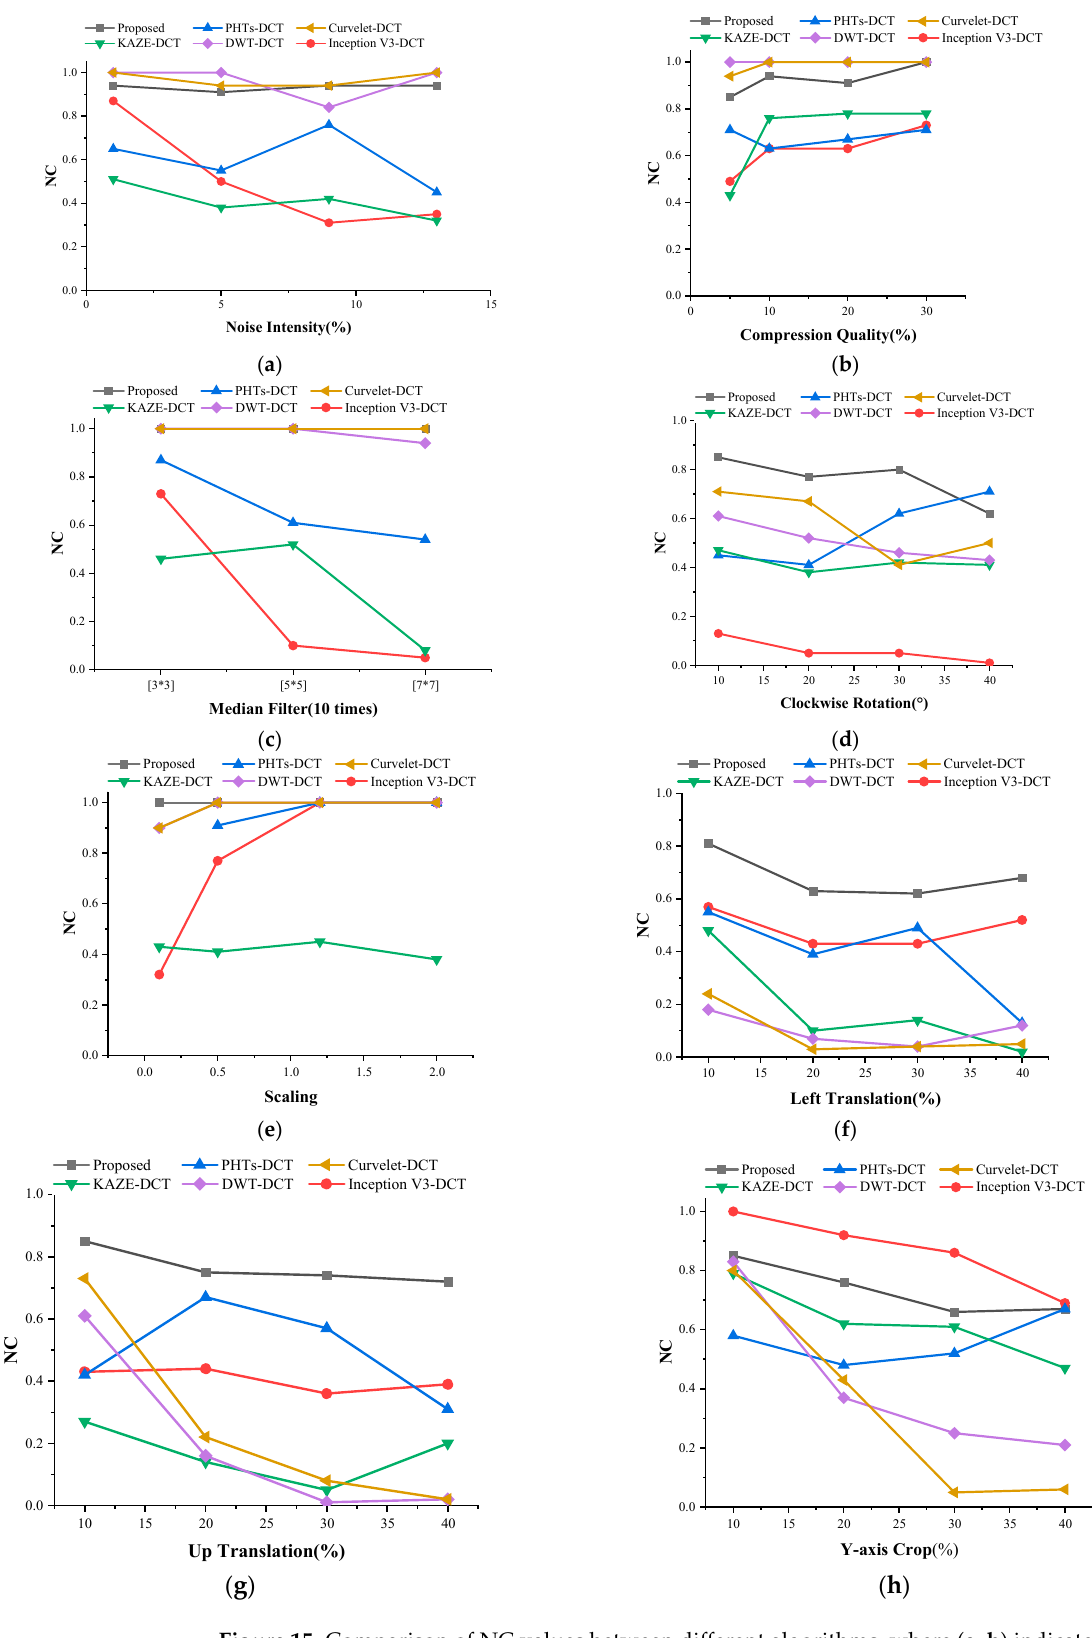
Figure 15. Comparison of NC values between different algorithms, where ( a – h ) indicate the results after Gaussian noise, JPEG compression, median filter, clockwise rotation, scaling, left-shift, up-shift, and Y-axis shear attacks, respectively.